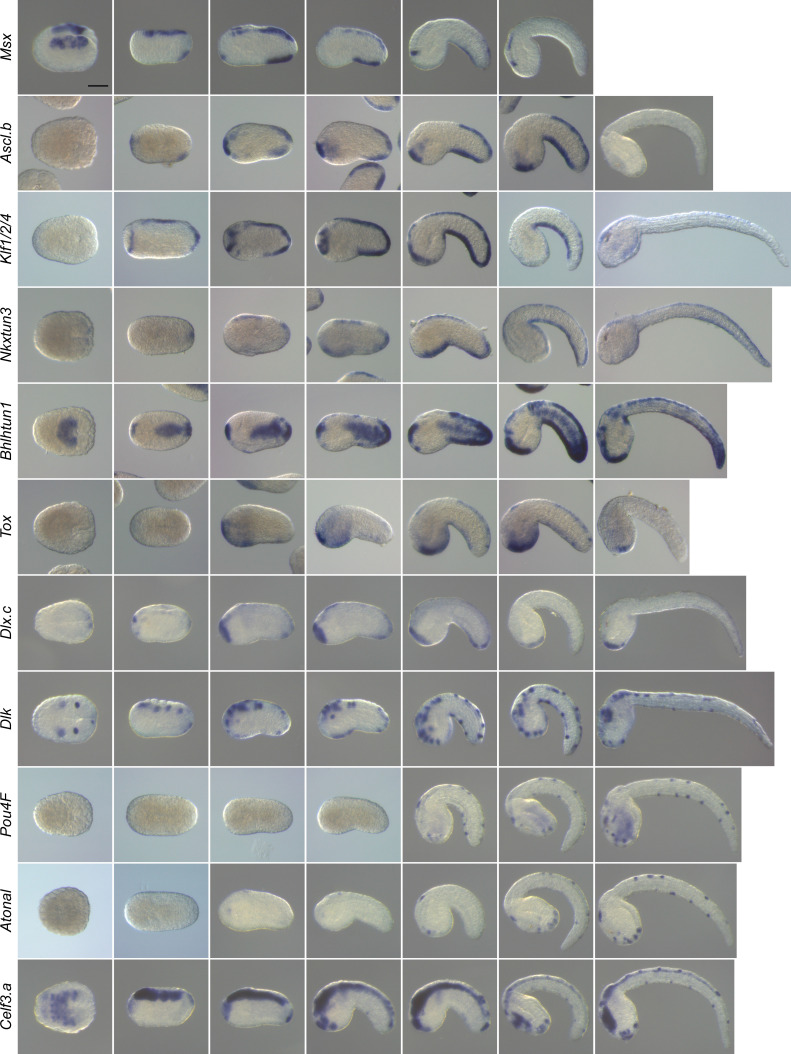
Expression pattern of caudal PNS genes in Phallusia mammillata.In situ hybridization results at several developmental stages for the P. mammillata orthologs of the C. intestinalis caudal PNS genes: Msx, Ascl.b, Klf1/2/4, Nkxtun3, Bhlhtun1, Tox, Dlx.c, Dlk, Pou4F, Atonal, and Celf3.a. Scale bar: 50 μm.